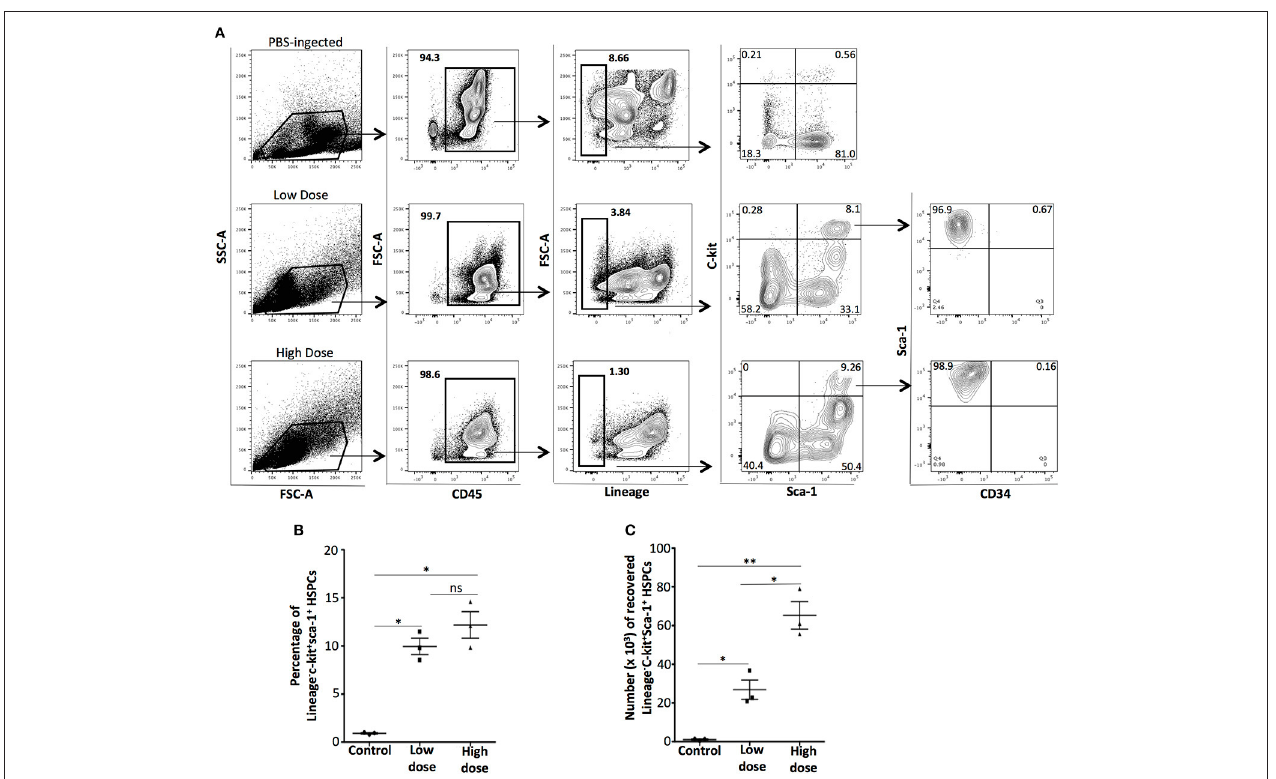
FIGURE 2 | Zymosan induces the emergence of bone marrow-derived hematopoietic stem/progenitor cells to the site of inflammation. WT C57BL/6 mice were injected with high- or low-dose of zymosan and after 24h cells in the peritoneal cavity were harvested and used for FACS analysis. (A) Cells from the peritoneal cavity of zymosan-injected mice were stained for CD45, Lineage, CD117 (c-kit), Sca-1, and CD34. Intraperitoneal injection of zymosan induces the emergence of a population of CD45 + Lineage − c-kit + Sca-1 + CD34 − cells, a phenotype corresponding to early hematopoietic stem/progenitor cells. One representative flow cytometry analysis is shown from 3 independent experiments ( n = 3). (B,C) In both low- and high-dose of treatment, a significant increase of the percentage of the recovered HSPCs has noticed whereas the absolute total number of HSPCs in high-dose zymosan is higher compared to low-dose treated mice ( n = 3). ** p < 0.005, * p < 0.05. (CD19), dendritic cells (CD11c), macrophages (F4/80, CD11b) and markers of innate lymphoid cells (Lineage, CD127, and Sca- 1). The congenic markers CD45.1 and CD45.2 were used